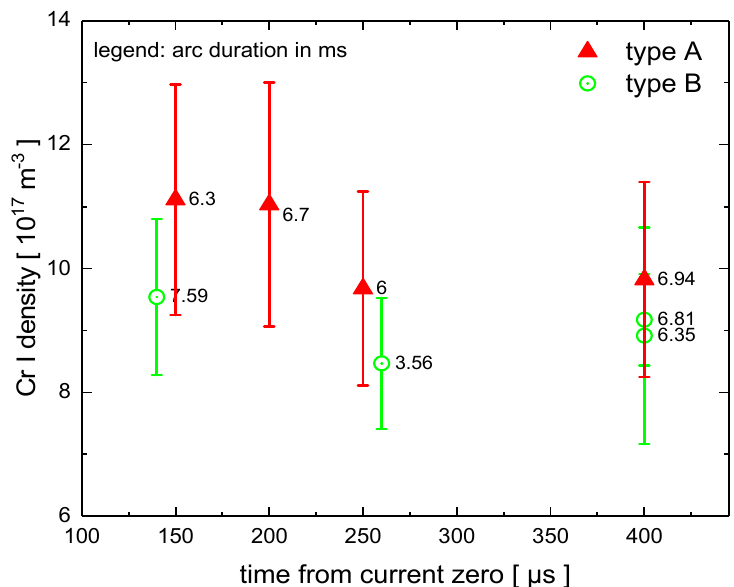
Figure 10. Cr I density measured after current zero crossing for different shots with contact systems of type A (red symbols) and B (green symbols). The numbers indicate the arc duration in ms.